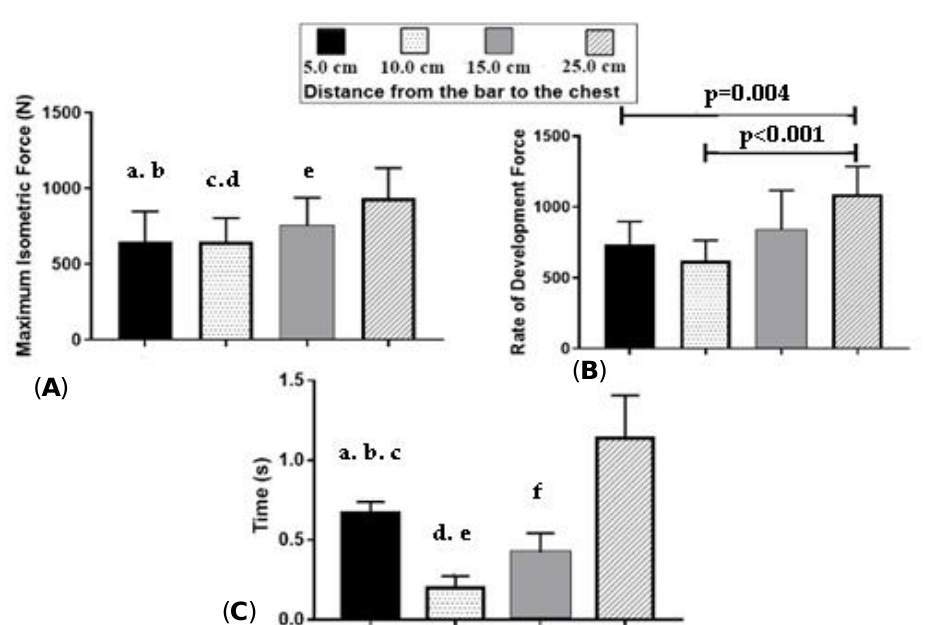
Figure 4. ( A ) Maximum isometric force (MIF), ( B ) rate of force development (RFD), and in relation to ( C ) time, with 5.0; 10.0; 15.0; and 25. cm of the distance from the bar to the chest.